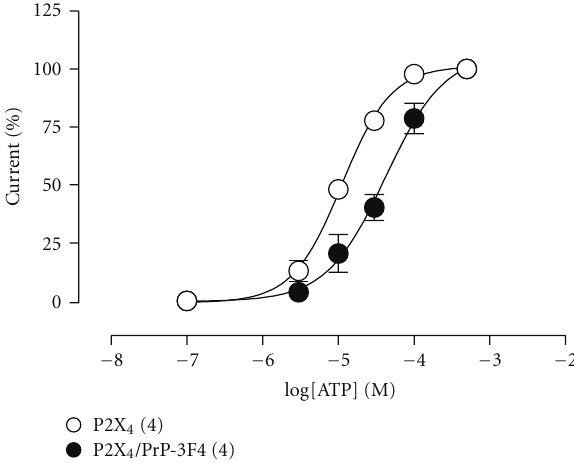
Figure 2: ATP concentration-response curves from oocytes expressing P2X 4 receptor (open circles) or co-expressing P2X 4 receptor and PrP-3F4 (closed circles). Symbols are mean values ± SEM, numbers in parenthesis are number of